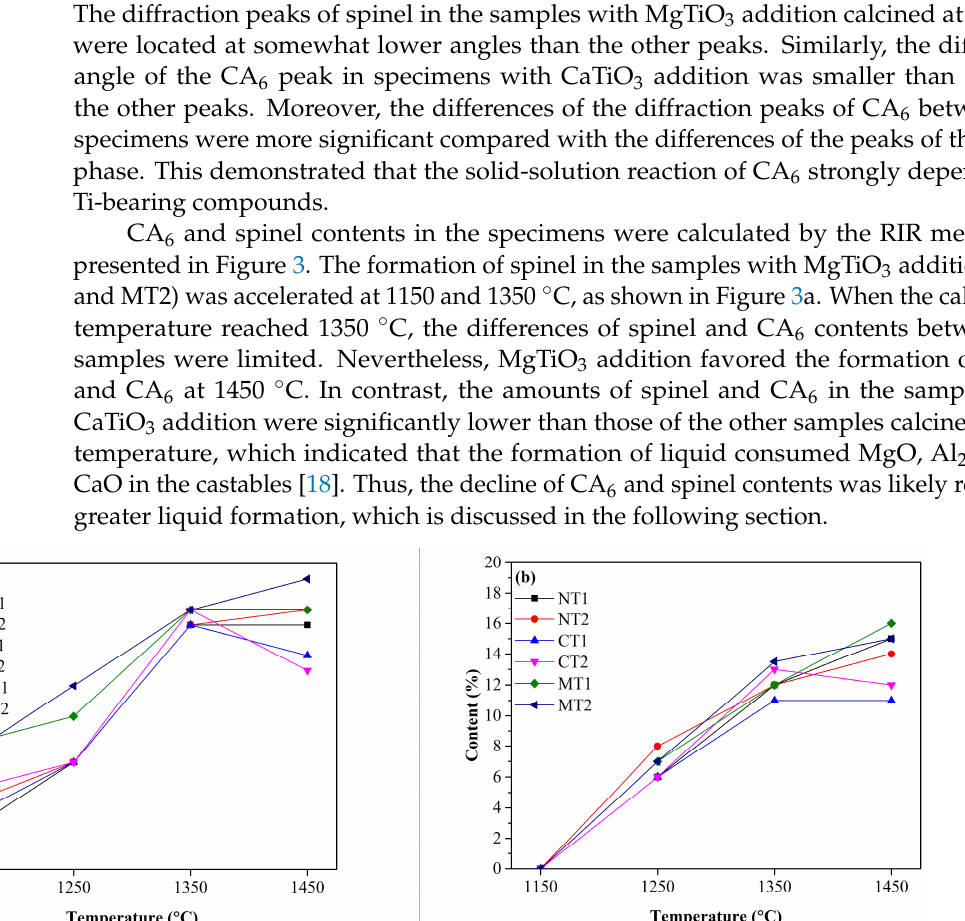
Figure 2. The shift of diffraction angle of spinel and CA 6 in samples calcined at different tempera- tures: ( a ) spinel and ( b ) CA 6.